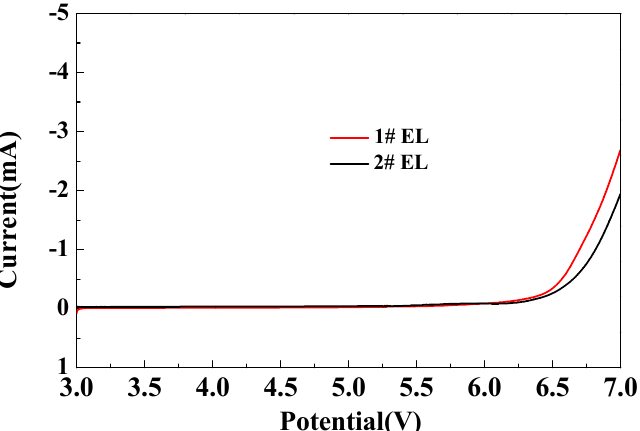
Figure 3. The LSV plots of the different electrolytes without additive and with 0.5% DDDT over a voltage range from the open-circuit voltage (OCV) to 7.0 V. The dQ/dV curve of the full battery containing 1–2 wt.% DDDT electrolyte shows a characteristic peak at around 2.8 V, which is lower than the reference group, indicating that the addition of DDDT is more beneficial than the addition of EC to the formation of the protective film on the negative electrode (Figure 4).